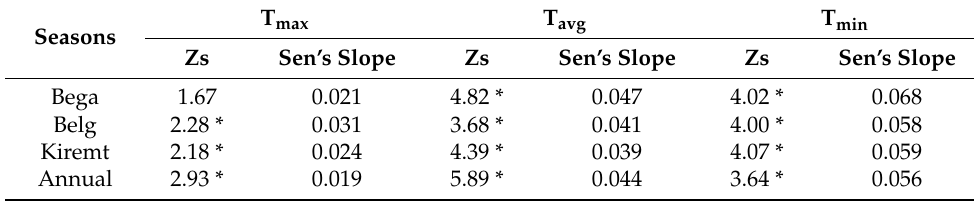
Table 4. The M–K test and Sen’s slope results of the maximum (T max ), the average (T avg ), and the minimum (T min ) temperatures for the period